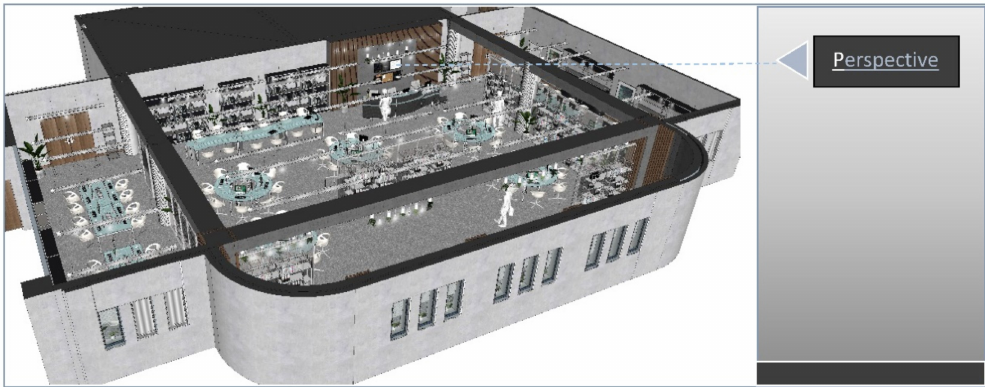
Figure 7. The perspective of the academic library.